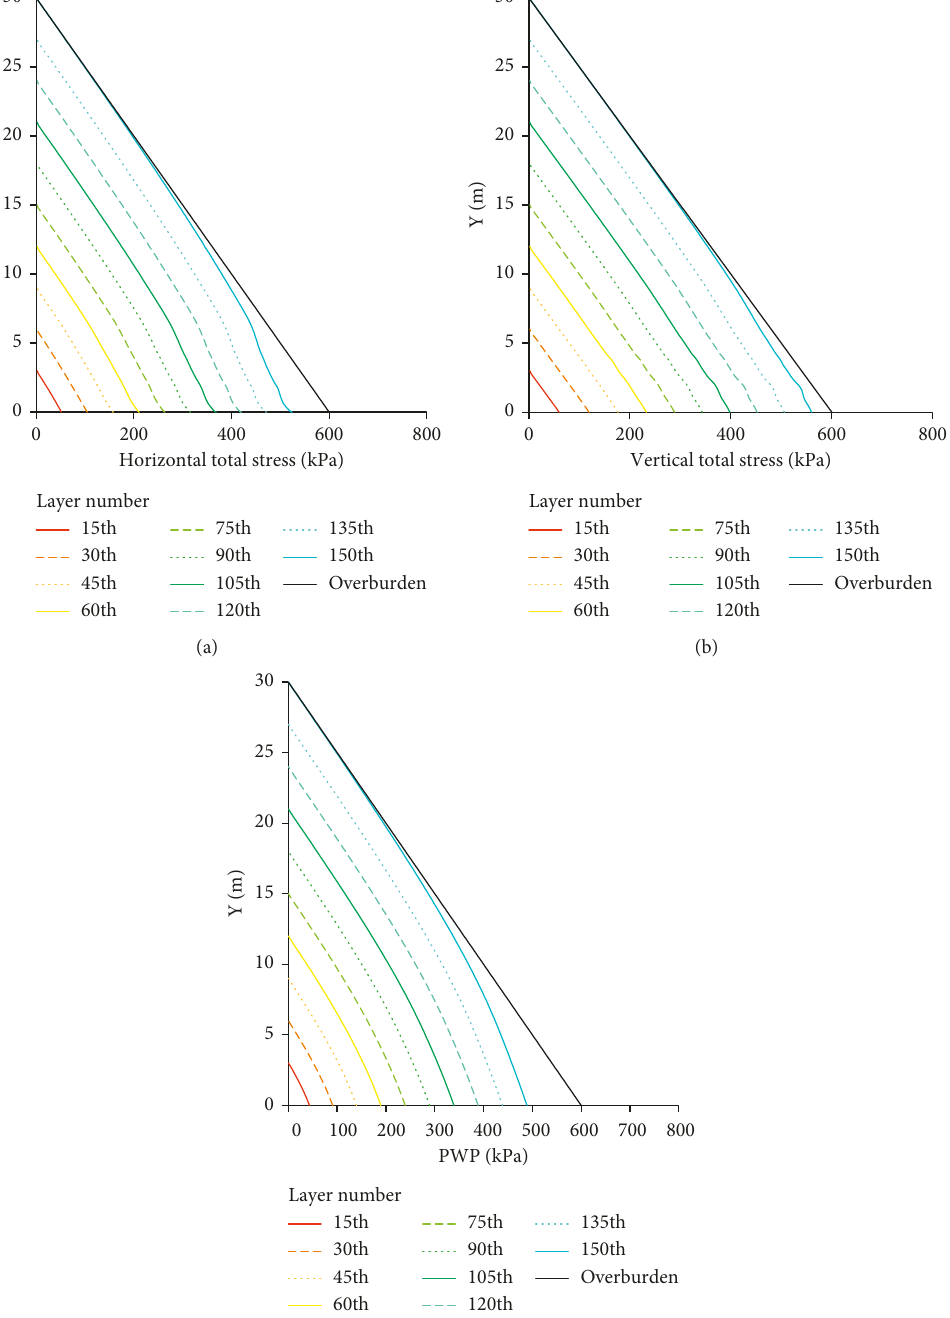
(Figure 9(a)) and u w (Figure 9(b)) at midheight on the barricade, from the start of backfilling for stopes having a width of 3, 6, and 9 m. Both the horizontal total stress and PWP reach a peak value after about 4.14 days from the beginning of stope filling, independently on the stope width;